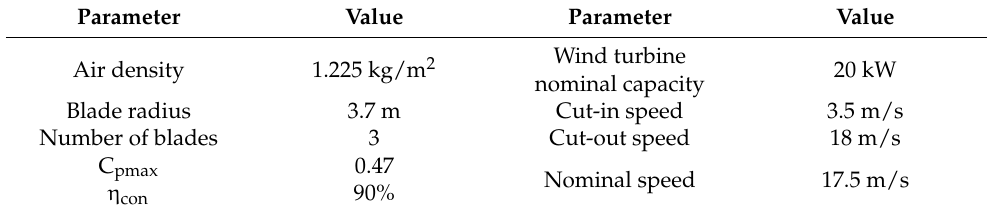
Table 5. Specifications of WEC system.